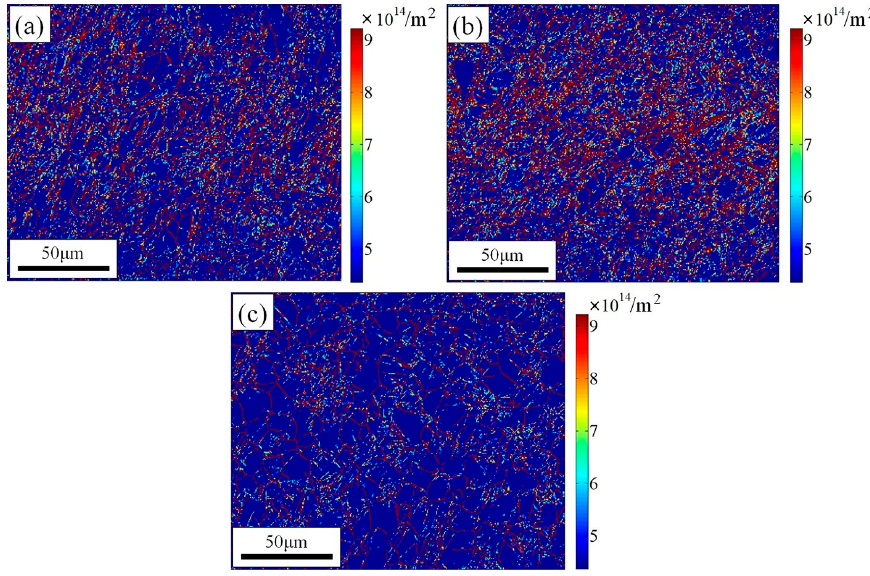
Figure 6. Geometrically necessary dislocation (GND) distributions in the NiTiFe SMA subjected to ECAE at various temperatures: ( a ) 400 °C; ( b ) 450 °C; ( c ) 500 °C.